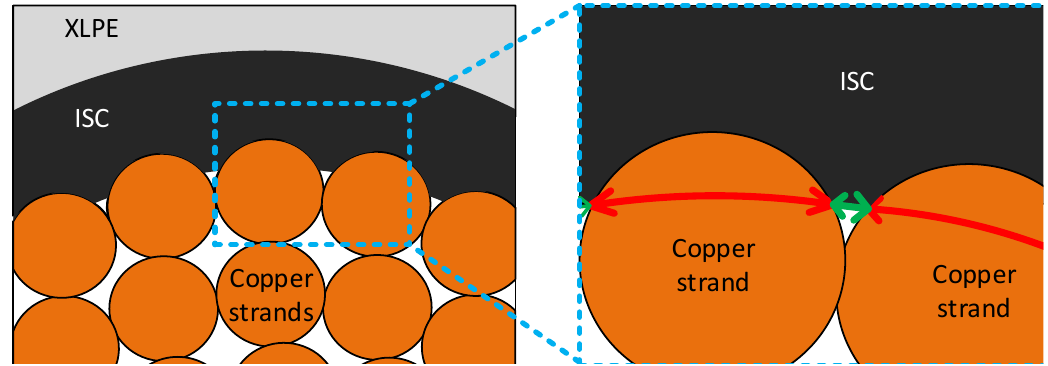
Figure 9. A schematic of an XLPE insulated power cable near the cable conductor, representing two boundary conditions, open (green arrow) and no-flow (red arrow) boundaries. Table 2. Lengths of open and no-flow boundaries with respect to C l